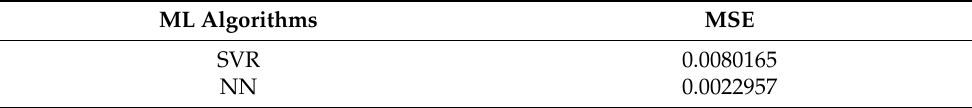
Table 4. MSE of ML